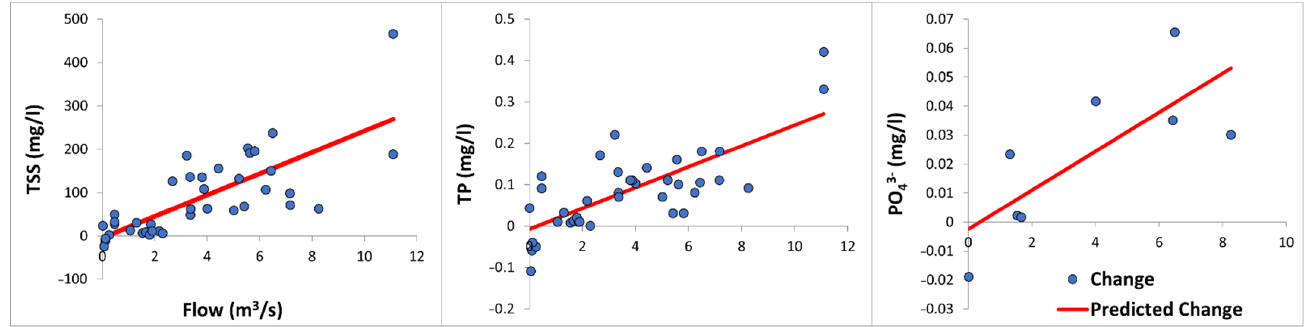
Figure 3. Regression plots for the three constituents that displayed a stronger relationship (adjusted R square > 0.5) between change in concentrations during transport along the Upper Qu’Appelle River with flow rate. Flow is average daily flow in m 3 /s at the WSA gauging station Elbow Diversion.